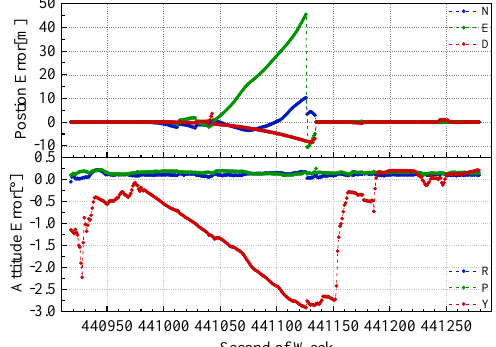
Figure 15. Position and attitude errors of the GNSS / INS integrated navigation system in the urban area test.